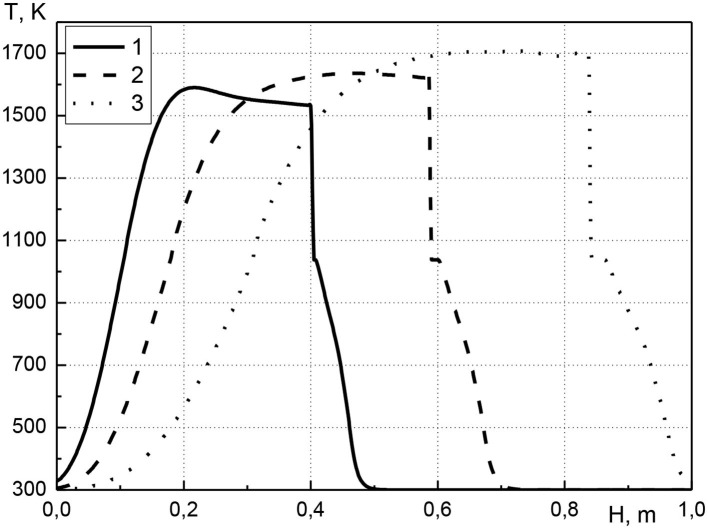
Condensed phase temperature profiles at time t = 1,500 s. 1–p01 = 1.005 atm; 2–p01 = 1.01 atm; 3–p01 = 1.02 atm.